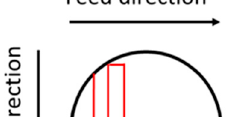
Figure 1. Scheme of the meandering pattern used for deep rolling and microblasting with indication the feed and the rolling